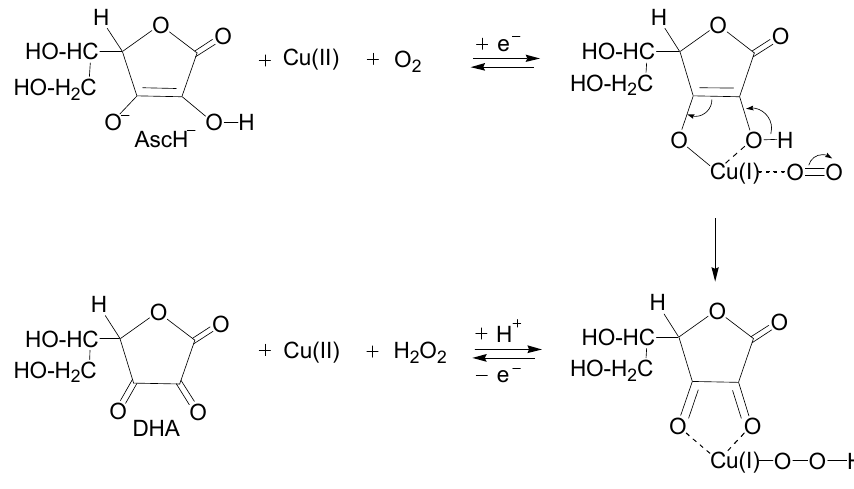
Scheme 1. Chemistry of WBOS (Weisberger biogenic oxidative system). AscH − and